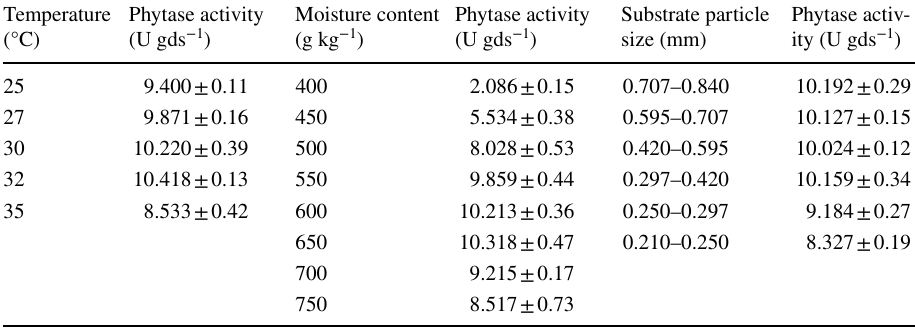
Table 4 Effect of different physical parameters on phytase